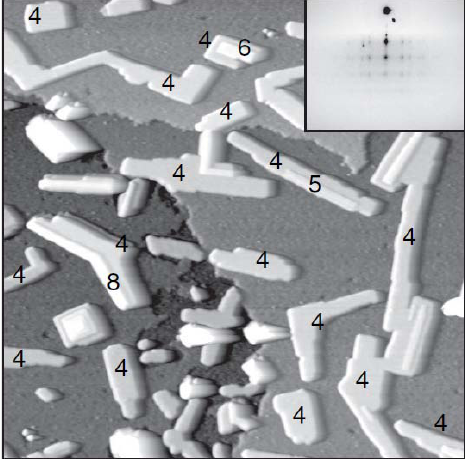
Figure 18. STM topography (400 × 400 nm 2 ) of the fivefold Al coverage of 4.5 ML Bi. Island heights are indicated in units of Bi(012) ML. The